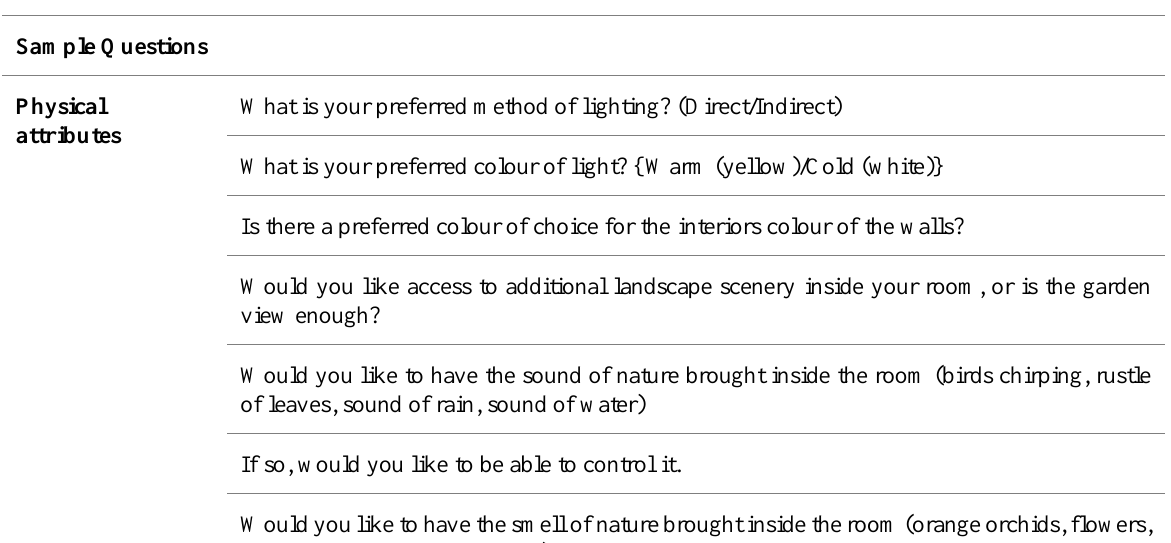
Table 2: Sample of interview questionnaire for personalization of personal